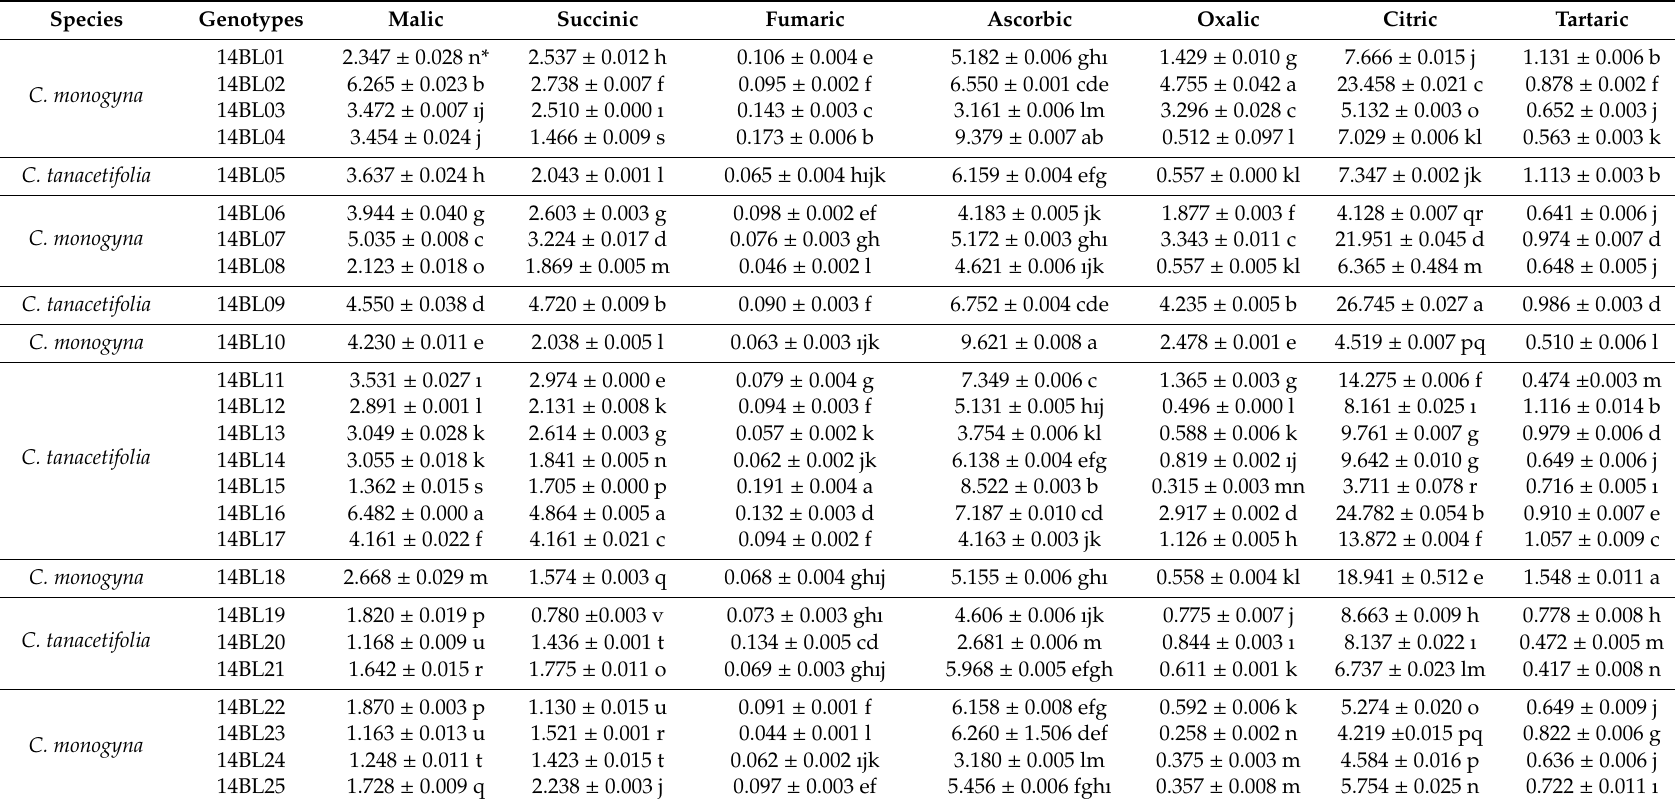
Table 1. Organic acid (g 100 g − 1 ) and ascorbic acid (mg 100 g − 1 ) contents of hawthorn